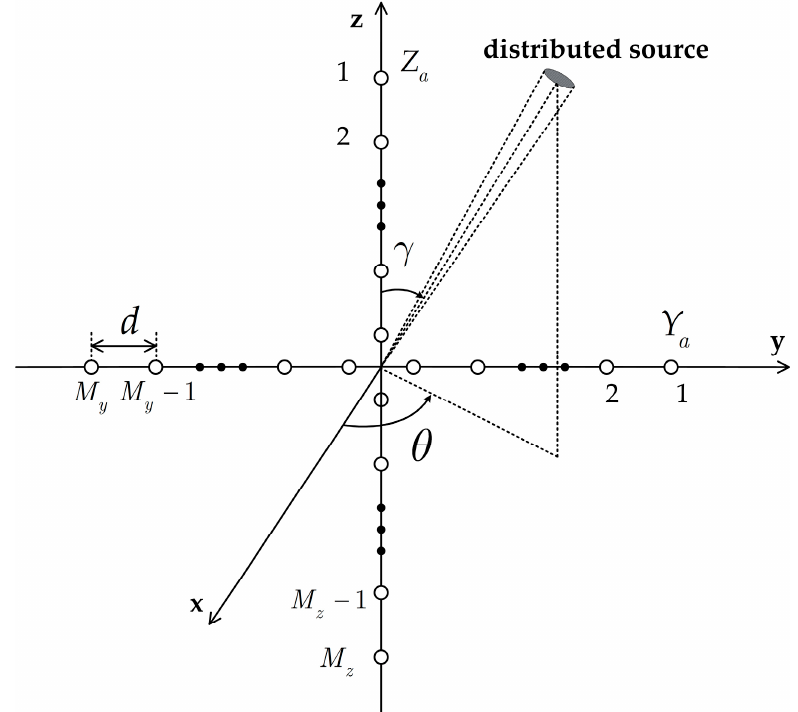
Figure 1. Geometry of the considered crossed array.